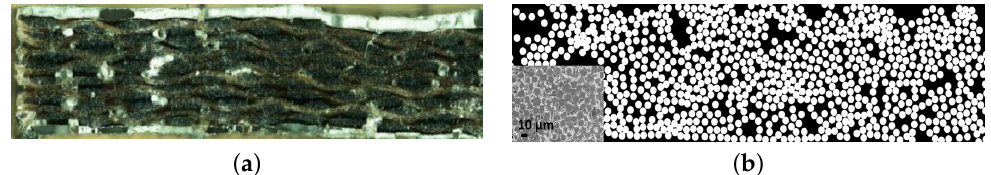
Figure 2. ( a ) Example of laminate made of basalt fabric bonded to epoxy matrix, ( b ) example of yarn cross-section.